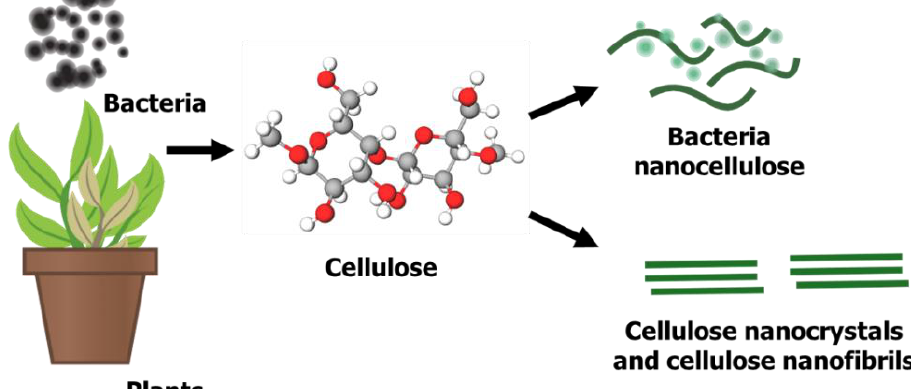
Figure 1. Formation of nanocellulose from cellulose-containing materials.